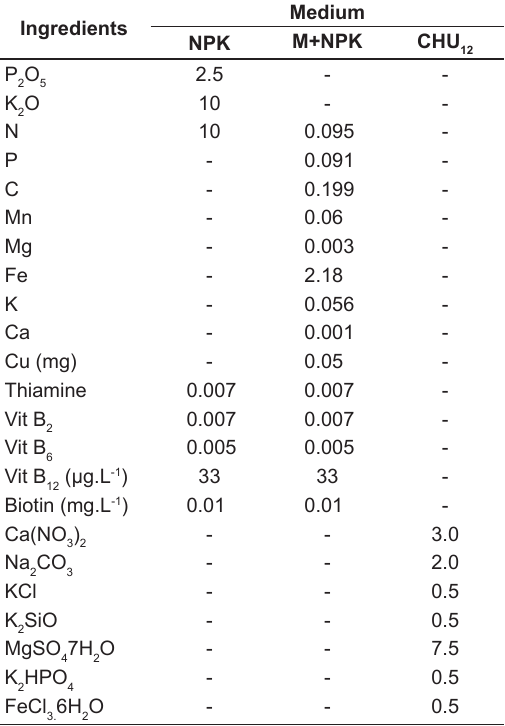
Table 1. Composition of nutrients (g.L -1 ) of different culture media: NPK; Macrophyte with NPK (M+NPK) and CHU 12